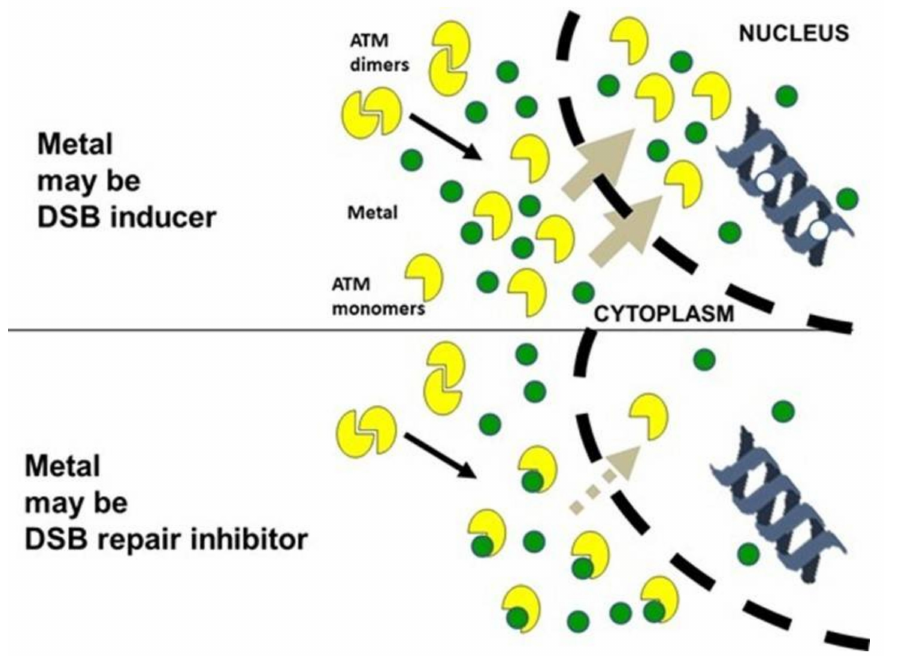
Figure 10. Mechanistic model of metal action. As detailed in the discussion, the presence of metal species may contribute to monomerizing ATM and/or inducing DSB. If the nucleo-shuttling of ATM is delayed, DSB will be not recognized by the NHEJ pathway. There are two possible consequences: either DSB are unrepaired, which triggers cell death and toxicity, or DSB are misrepaired by an alternative DSB repair pathway, which triggers genomic instability and